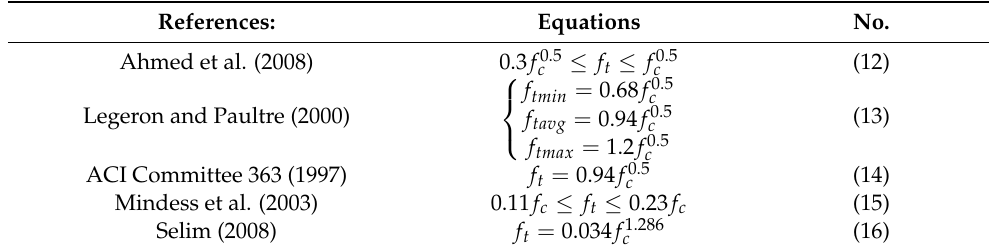
Table 4. Relationship between compressive and flexural tensile strength adapted from Chamroeun et al., 2017 [47].